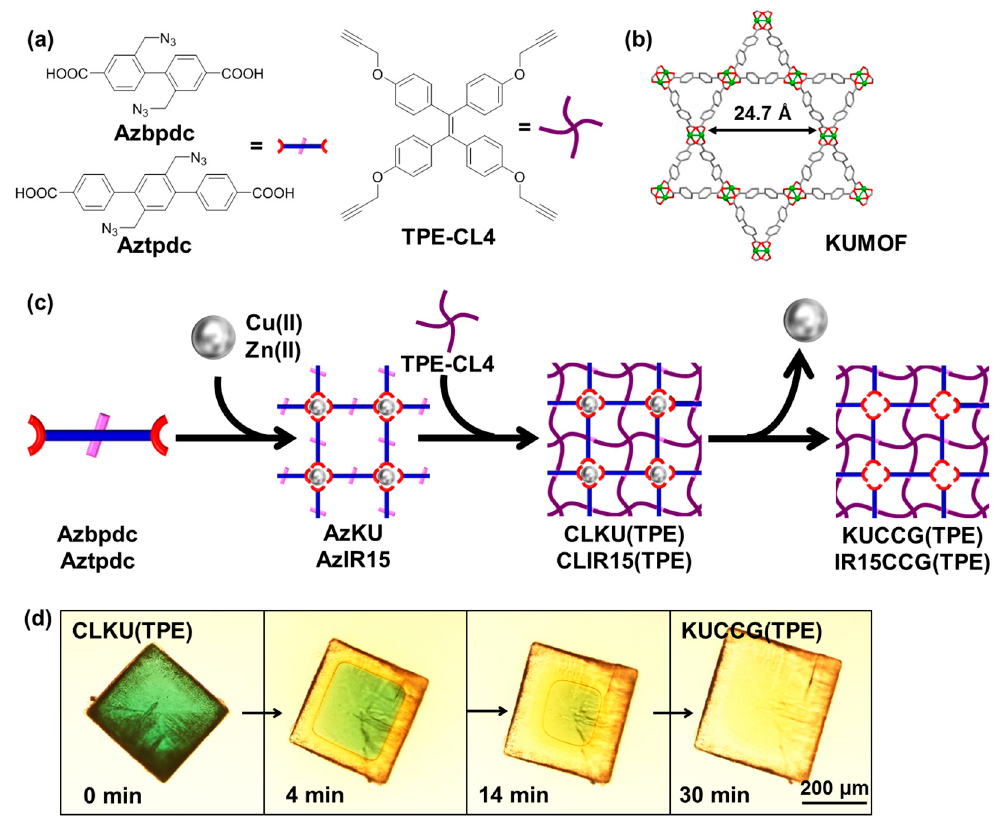
Figure 1. ( a ) Chemical structures of organic ligands, azide-functionalized biphenyl dicarboxylic acid (Azbpdc) and azide-functionalized terphenyl dicarboxylic acid (Aztpdc), and TPE-derived tetrapropargyl crosslinker (TPE-CL4); ( b ) Pore aperture of KUMOF from single crystal data [30]; ( c ) Schematic representation of crystal crosslinking method to obtain crystal crosslinked gel from azide-functionalized KUMOF (AzKU) (KUCCG(TPE)) and from azide-functionalized IRMOF-15 (AzIR15) (IR15CCG(TPE)) via crosslinked AzKU and AzIR15 with TPE-CL4 denoted as CLKU(TPE) and CLIR15(TPE); ( d ) Time-course observation of hydrolysis of CLKU(TPE) to obtain KUCCG(TPE) in conc. HCl/DMF = 1/5 ( v / v ).